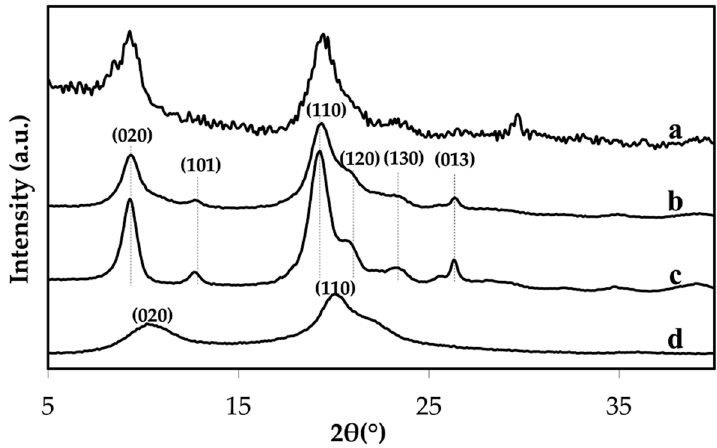
Figure 2. X-ray diffractograms of crab shell ( a ), extracted chitin ( b ), commercial chitin ( c ), and commercial chitosan ( d ). Table 3. Crystallinity index (%CrI), degree of acetylation (%DA), and peak temperature of extracted chitin, commercial chitin, and commercial